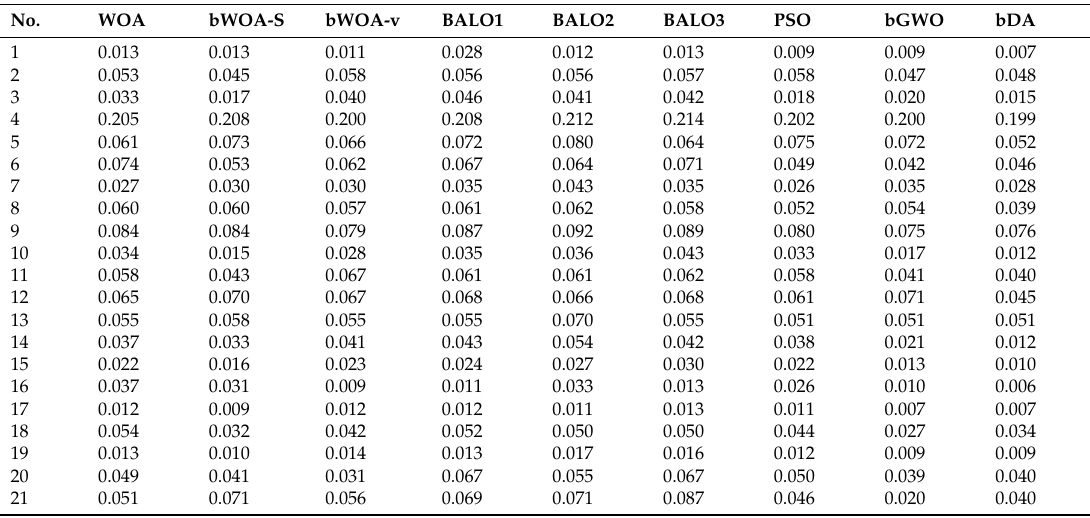
Table 10. Standard deviation fitness function on the different datasets averaged for the compared algorithms over the three initialization